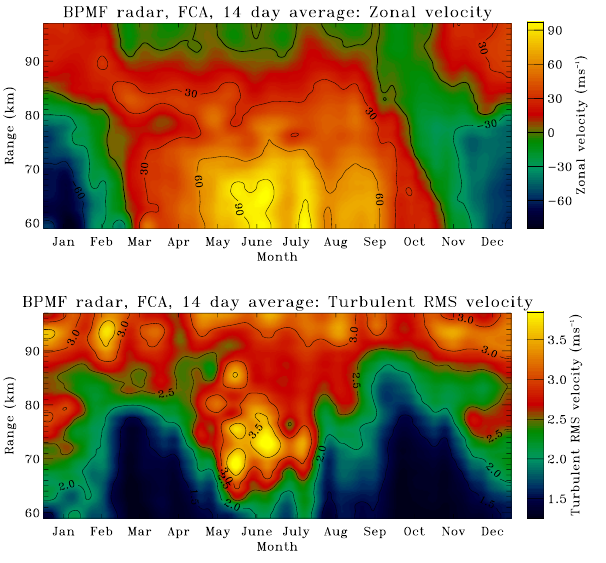
Fig. 3. Superposed epoch image plot of the annual variation of Figure3.SuperposedepochimageplotoftheannualvariationofZonalandTurbulent zonal (top) and turbulent (bottom) velocities between March 1999 velocitiesbetweenMarch1999andJune2000. and June 2000.